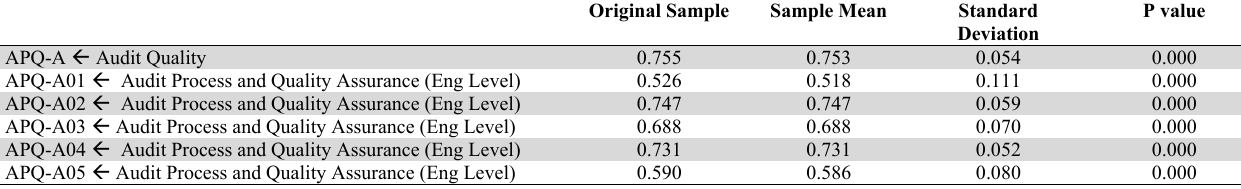
Original Sample